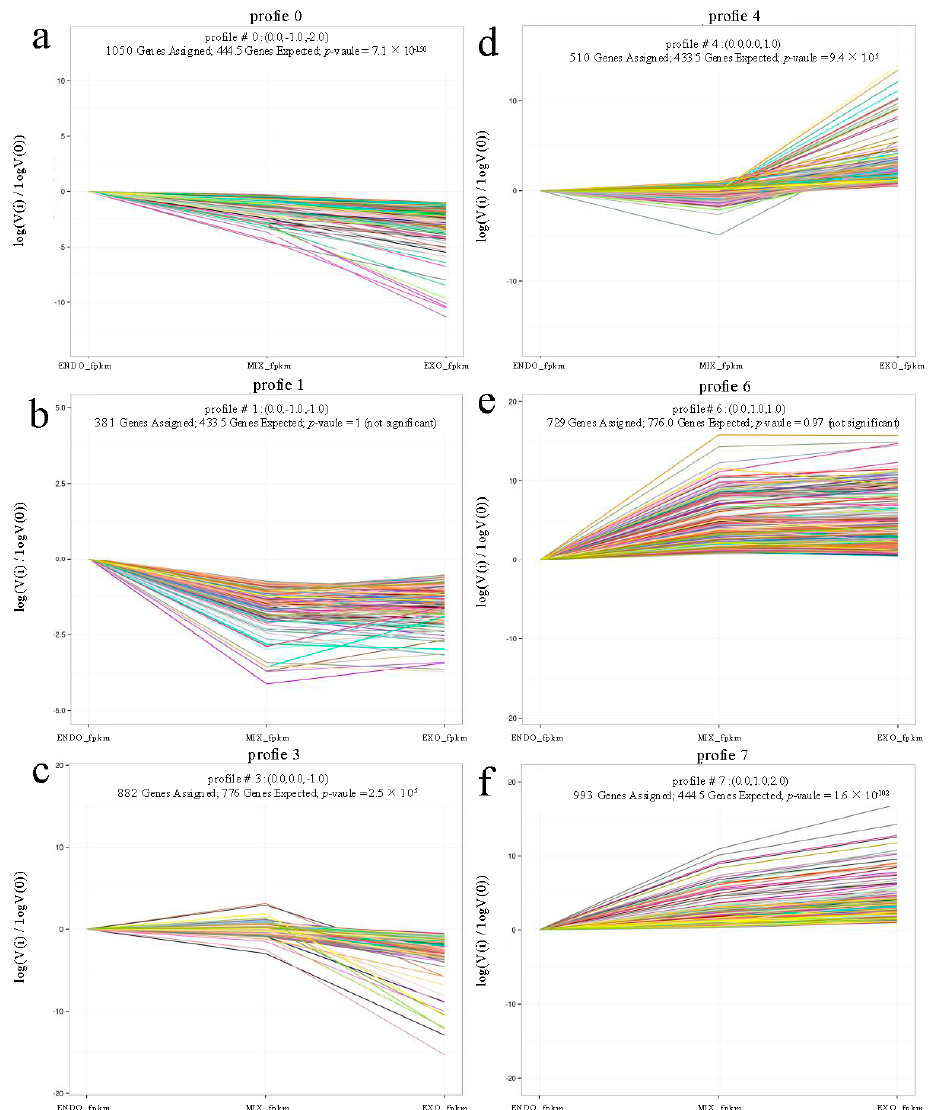
Figure 3. DEGs expression profiles from ENDO, MIX, and EXO: Profile 0 ( a ); Profile 1 ( b ); and Profile 3 ( c ) indicating down-regulated patterns; and Profile 4 ( d ); Profile 6 ( e ); and Profile 7 ( f ) indicating up-regulated patterns.